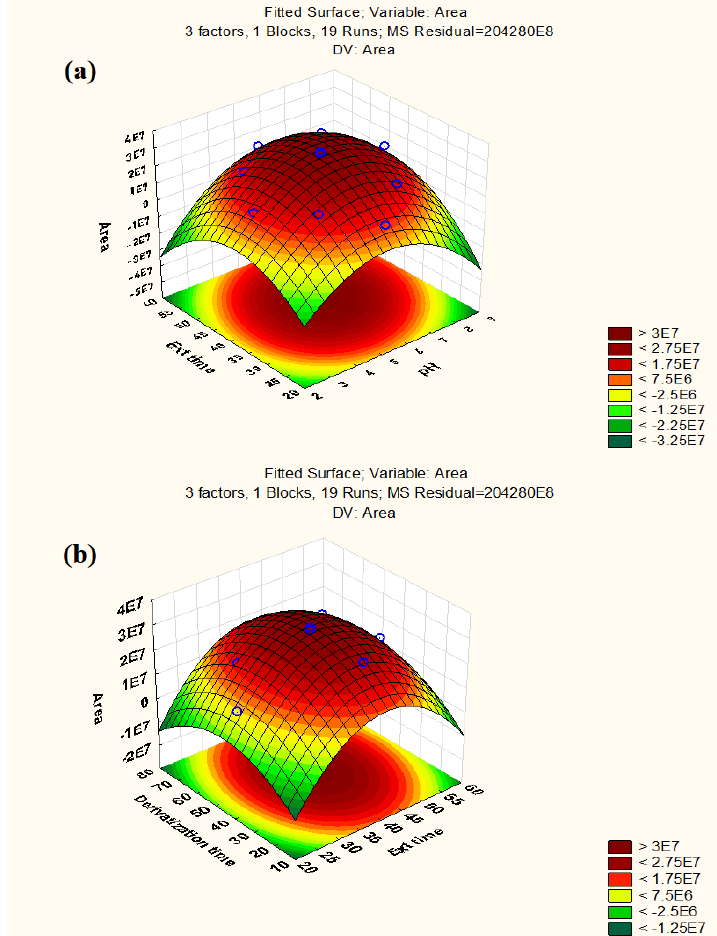
Figure 2. Response surface plots: ( a ) Extraction time vs. pH ( b ) Derivatization time vs. Extraction